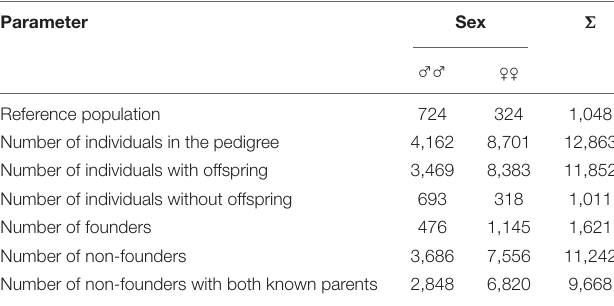
TABLE 3 | Pedigree structure in the analyzed population.